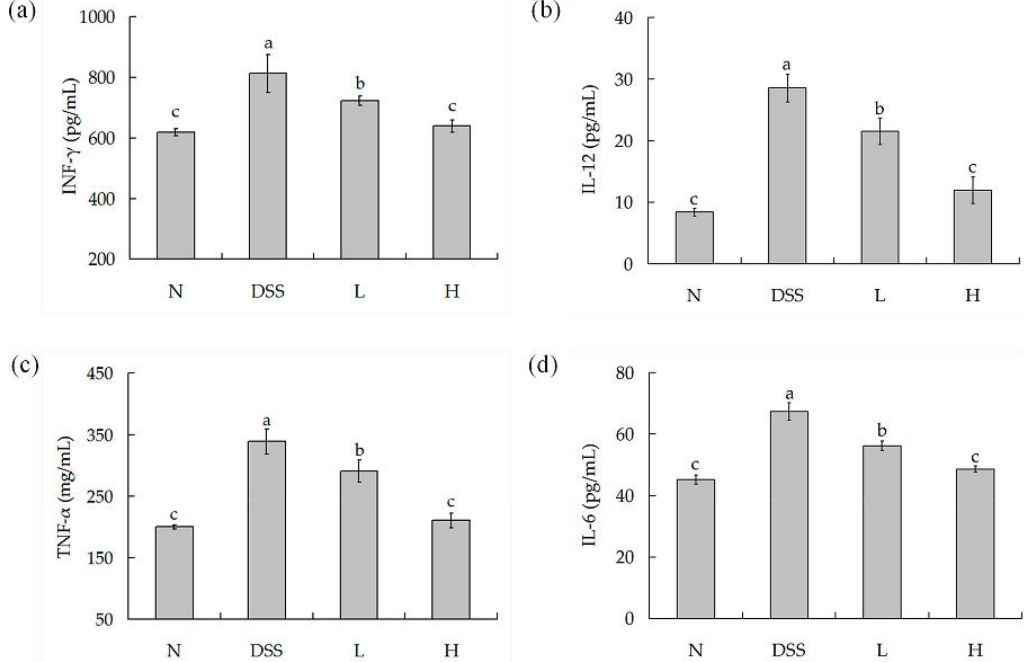
Figure 4. Pro-inflammatory factors concentrations in serum. ( a ) IL-6 cytokine level in serum; ( b ) IL-12 cytokine level in serum; ( c ) TNF- α cytokine level in serum; ( d ) IFN- γ cytokine level in serum. N (normal group), DSS (model group), L (low dose group, 10 9 CFU/kg · bw), H (high dose group, 10 10 CFU/kg · bw); a,b,c expressed as significant level, p < 0.05. TNF- α : Tumor necrosis factor- α ; IFN- γ : interferon- γ ; IL-6, 12: interleukin-6,